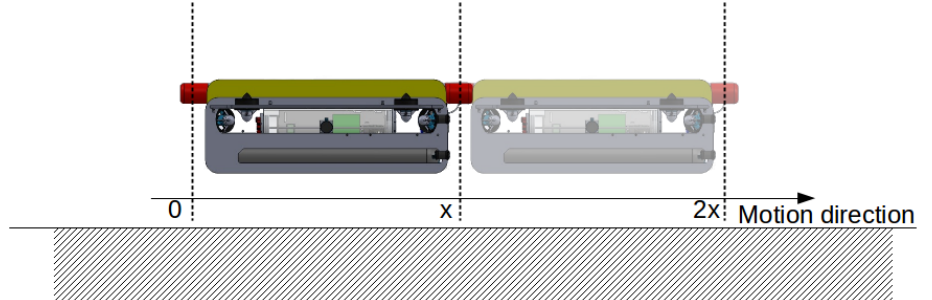
Figure 7. Impact of sampling with two sensors when the robot moves with constant velocity v = ( v ,0,0 ) and the distance between sensors is x . When s 1 , reaches the position of s 0 , phases must be shifted by 180 ◦